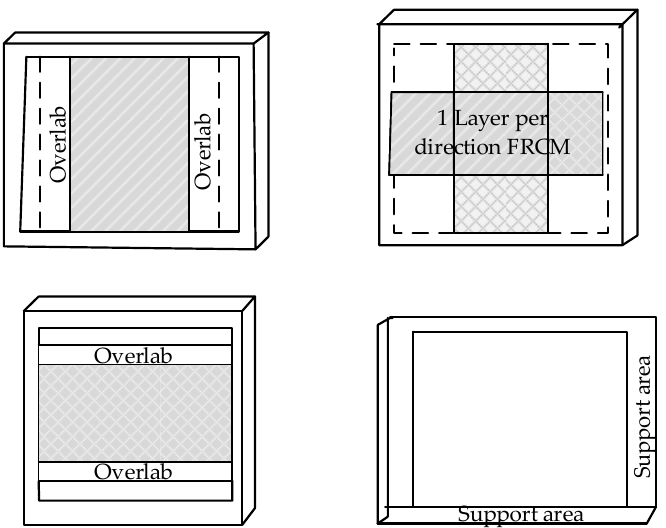
Figure 22. The different configurations of strengthened slabs at their tensile face [110].